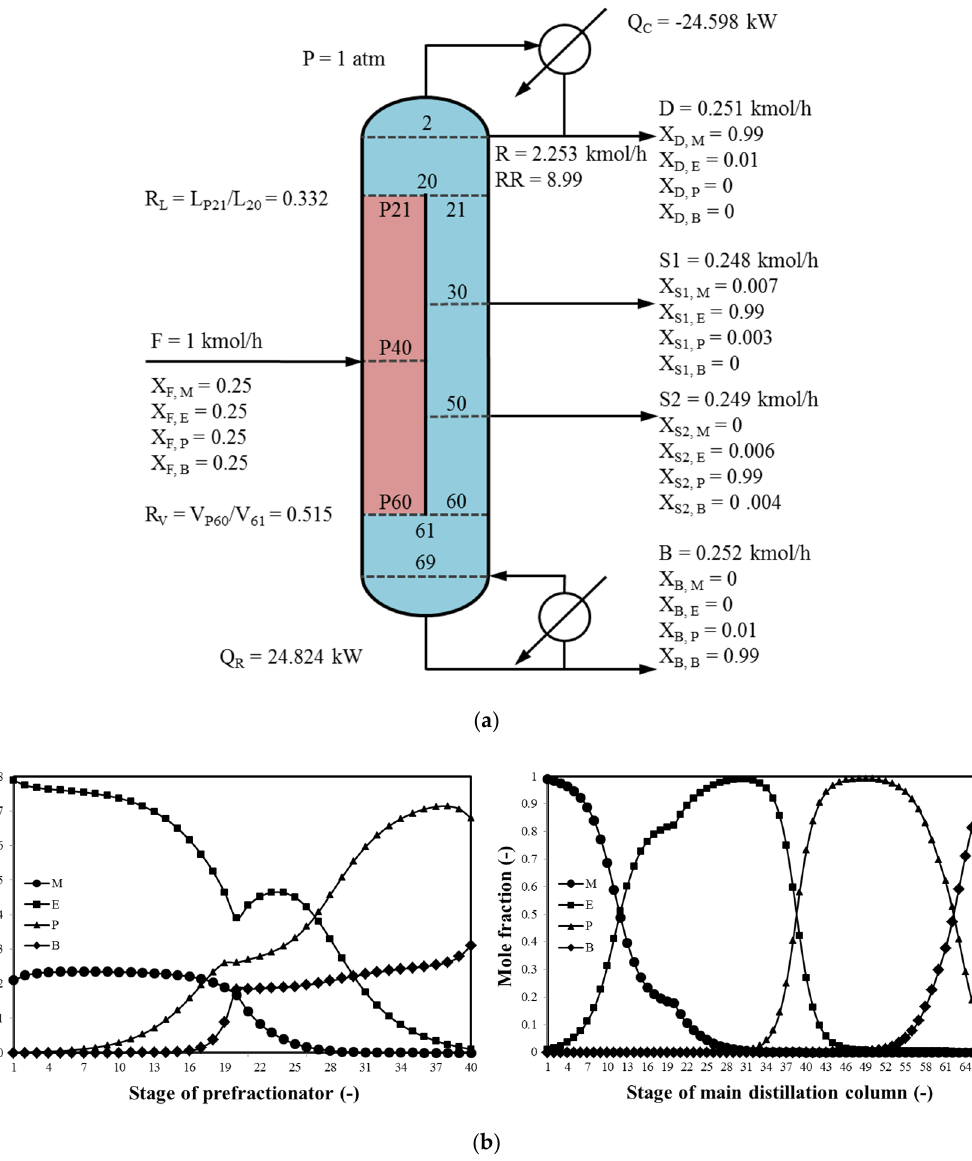
Figure 5. The optimum MEPB Kaibel distillation column and its static composition profiles: ( a ) MEPB Kaibel distillation column; ( b ) liquid composition profiles.